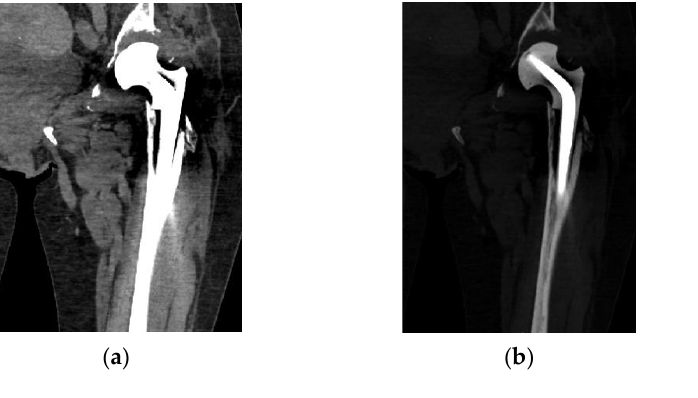
Figure 6. Result of the application of the procedure in the case of the occurrence of metallic structures: ( a ) Image with the DICOM data not processed; ( b ) Image with the DICOM data processed; and ( c ) Marking the part of an implant in the segmentation process.